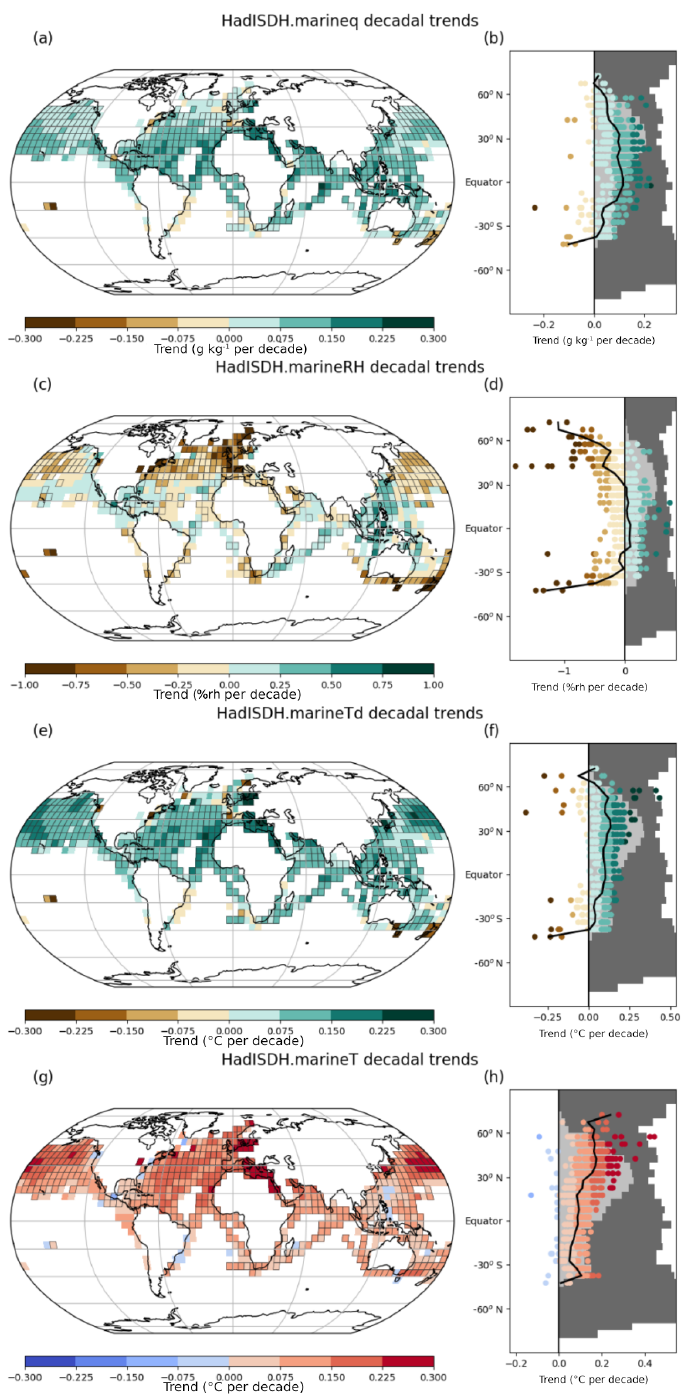
Figure 13. Linear decadal trends from 1973 to 2018 for (a, b) specific humidity (gkg − 1 ), (c, d) relative humidity (%rh), (e, f) dew point temperature ( ◦ C), and (g, h) air temperature ( ◦ C) for the third-iteration quality-controlled and bias-adjusted ships only. Decadal linear trends were fitted using ordinary least-squares regression when there are at least 70% percent of months present over the trend period. Grid boxes with boundaries show significant trends in that the 90% confidence interval (calculated with AR(1) correction following Santer et al., 2008) around the trend magnitude is the same sign as the trend and does not encompass 0. The right-hand panels (b, d, f, h) show the distribution of grid box trends by latitude with the mean shown as a solid black line. The dark grey shading shows the proportion of the globe at that latitude which is ocean. The light grey shading shows the proportion of the globe that contains